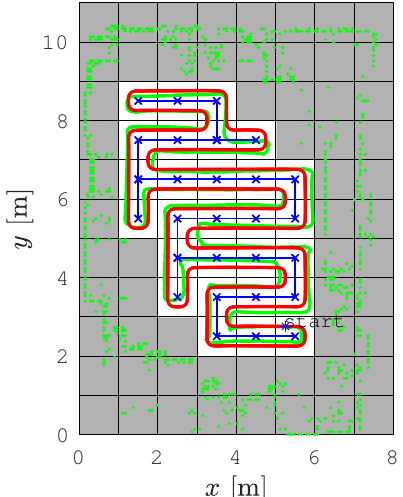
Figure 15. The calculated SCCPP path (red line) and trajectory tracked by the Pioneer 3DX robot (green